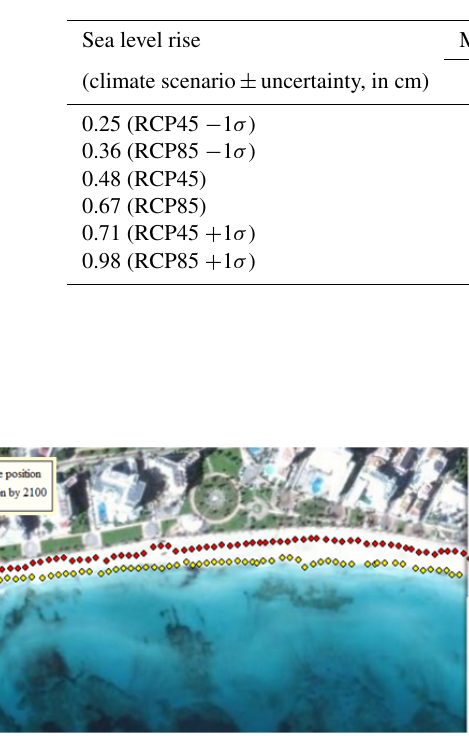
Figure 16. Changes in the cross profile in Cala Millor (a) and Playa de Palma (b) in the nearshore area under different sea levels. Table 6. Loss of aerial beach (defined here as the landward migration of the shoreline averaged over the entire beach) for both the mean and extreme conditions expected under climate change scenarios in Cala Millor (in m). For the extreme conditions, the maximum loss is also quoted.